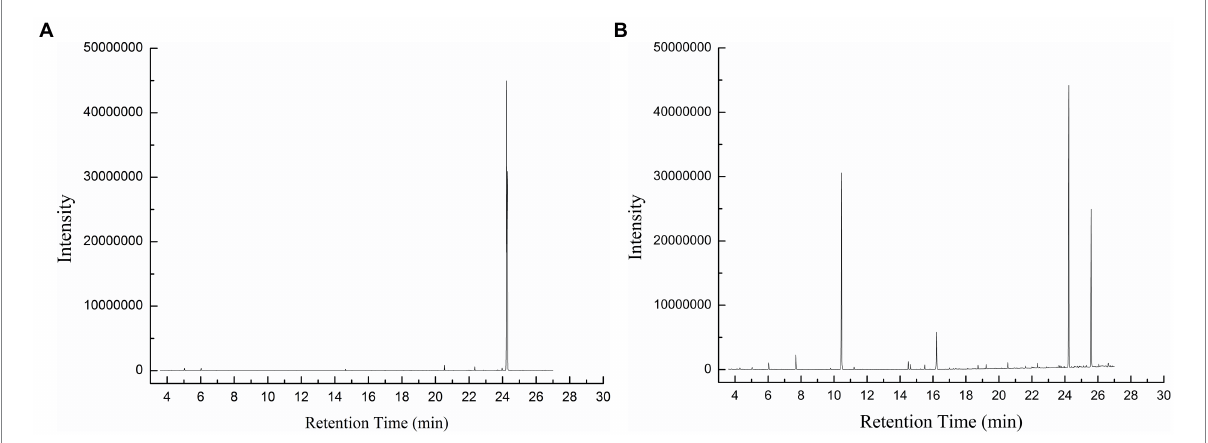
FIGURE 3 The GC–MS total ionic current (TIC) chromatogram of GGE and GGE-derived compounds. (A) GGE in control; (B) GGE-derived